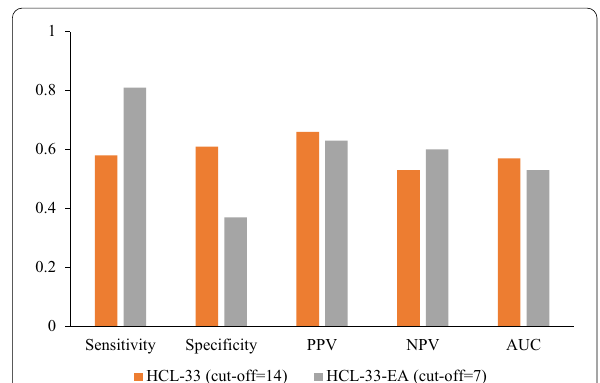
Fig. 1 Sensitivity, specificity, positive predictive value (PPV), negative predictive value (NPV), and area under the curve (AUC) for the Hypomania Checklist‑33 (HCL‑33) and Hypomania Checklist‑33 external assessment (HCL‑33‑EA) for Bipolar Disorder versus